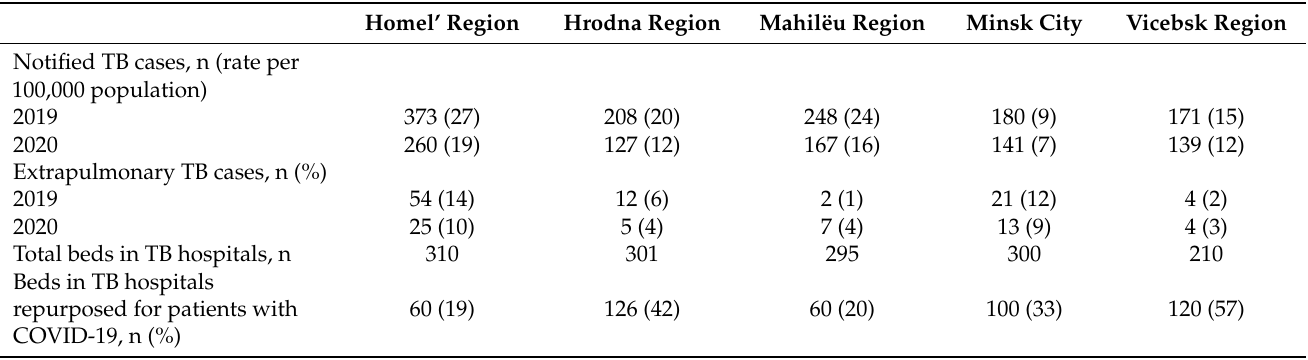
Table 1. Characteristics of the study